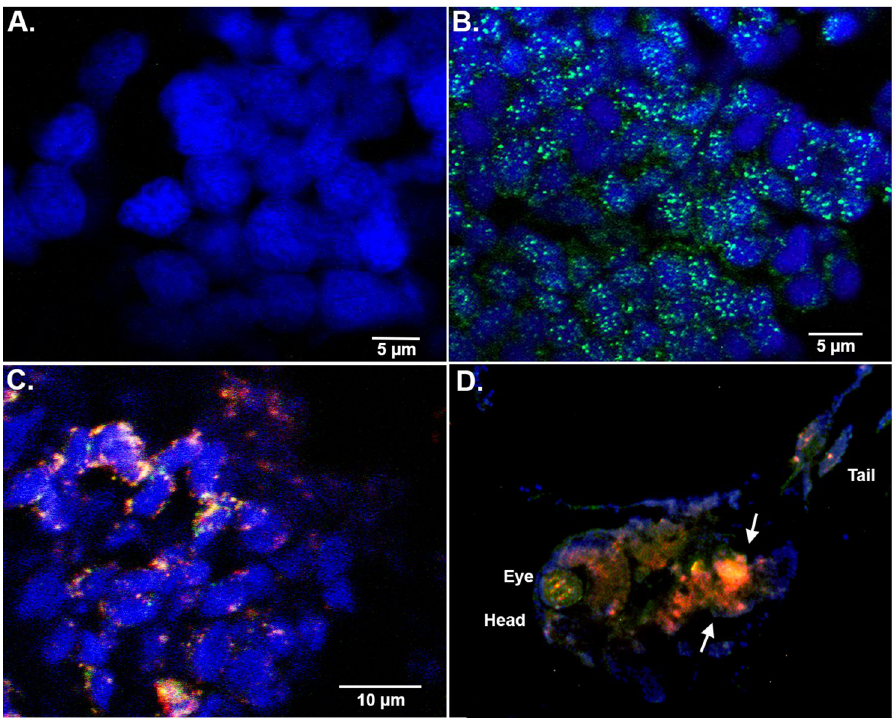
Fig 4. Exogenous treatment of zebrafish embryos with nApoE4 1-151 leads to nuclear localization. A-C. Representative images from confocal immunofluorescence in 5 mm paraffin-embedded sections that were stained with DAPI (A), anti-His antibody (green, B), or anti-His together with NeuN (C). There was no detection of nApoE4 1-151 fragments in untreated control neuronal cells as indicated by the lack of labeling in Panel A. Nuclear localization of the nApoE4 fragment was evident (Panels B and C) following exogenous treatment. For the E4 fragment, staining appears punctate and co-localized with NeuN and DAPI (B and C). All images were captured within the area of the cerebellum and fourth ventricle. D. Identical to Panels B-C with the exception that whole embryo mounts were triple labeled in order to display overall labeling in the entire organism at low magnification. Labeling of head, eye and tail is presented for orientation. The intense orange fluorescence area (arrows) represents regions with strong overlap between the E4 fragment and NeuN. In this case, labeling of the E4 fragment that co-localized with DAPI and NeuN was apparent in the hindbrain brain region. Data are representative of five independent